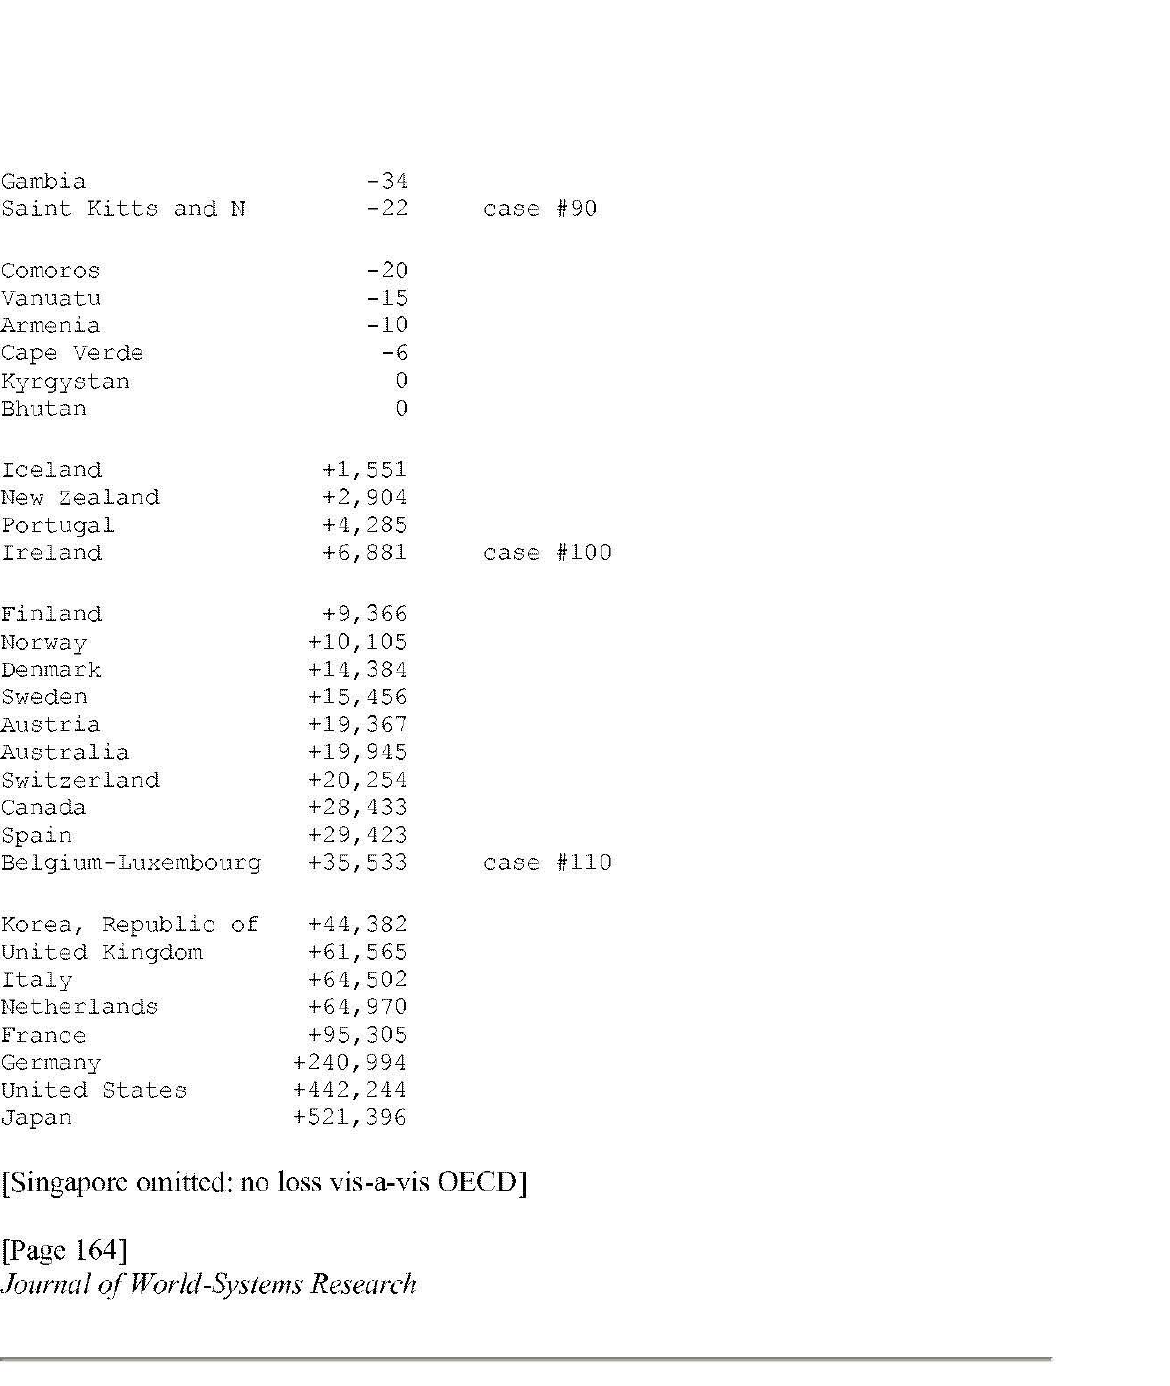
TABLE A-3 -- WORLD TABLE OF UNEQUAL EXCHANGE 1995: SORTED BY